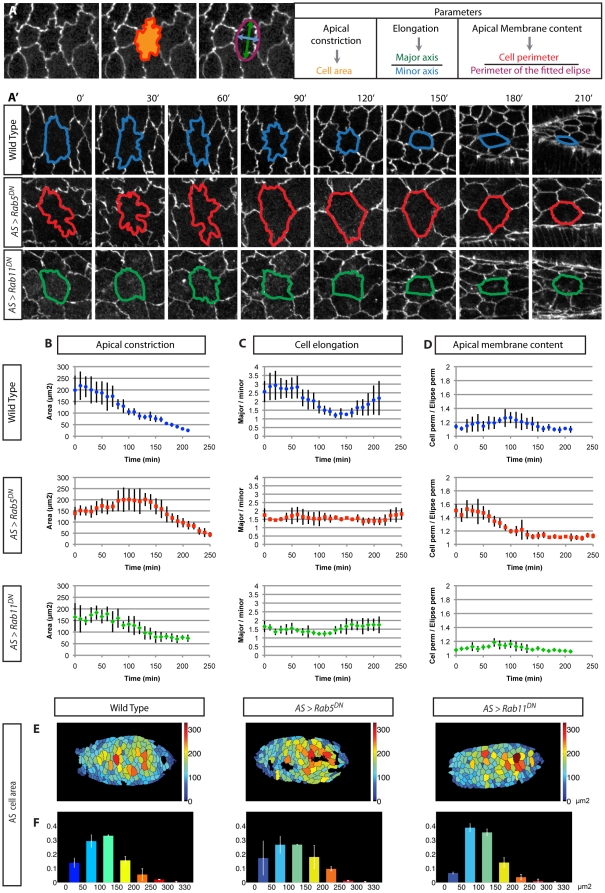
Quantification of AS apical membrane content, AS apical constriction and cell elongation.(A) Schematic representation of the three parameters measured in this study: apical surface area, elongation and membrane content. (A') Examples of AS cells followed in embryos of the indicated genotypes expressing Ubi-DE-CadherinGFP. (B–D) Quantification of apical surface area (B), cell anisotropy (C) and membrane content (D) for 5 cells of a representative embryo of each of the indicated genotypes. (E–F) Automated analyses of apical cell areas of the whole AS tissue in embryos at the beginning of DC. Cell area is shown with a colour code (E) and the proportion of cells in each cell area class is depicted in the bar graphs using the same colour code. In Rab5DN expressing embryos, cells are more evenly distributed among the different cell area classes when compared with wild type (F). In Rab11DN expressing embryos, the cell area is mostly concentrated in two cell area classes with small areas (F).